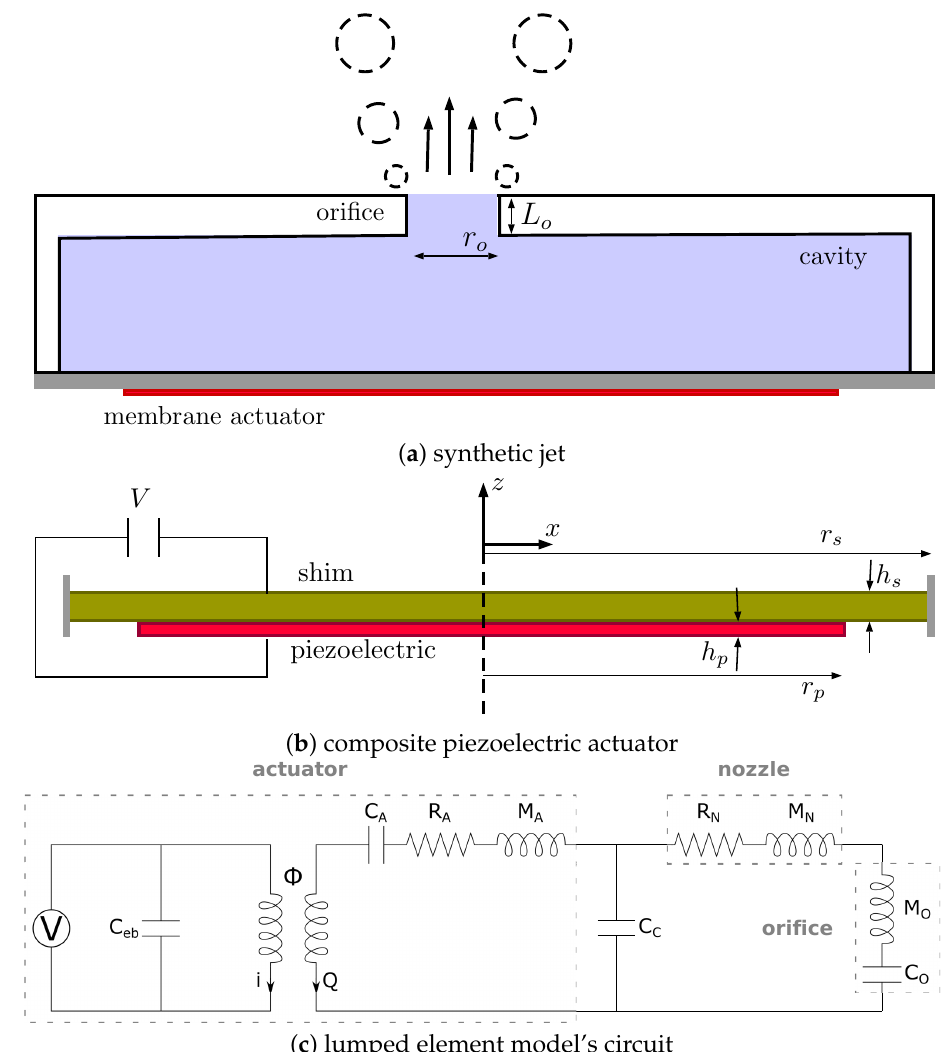
Figure 9. Details on the set-up of the synthetic jet case, including the construction of a typical device ( a ) including the composite actuator ( b ) and the lumped element model ( c